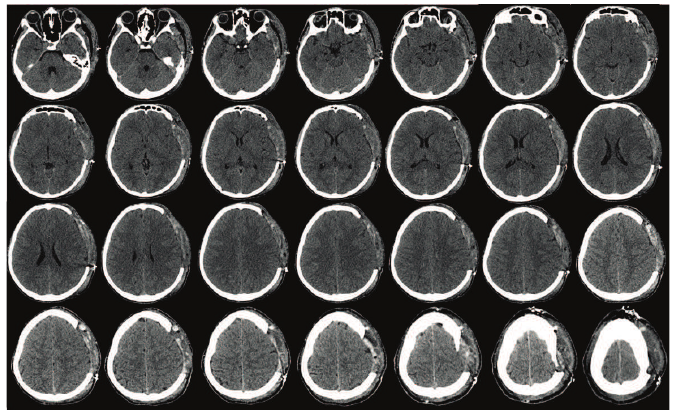
Figure 14. CT scan images of patient with parietal bone